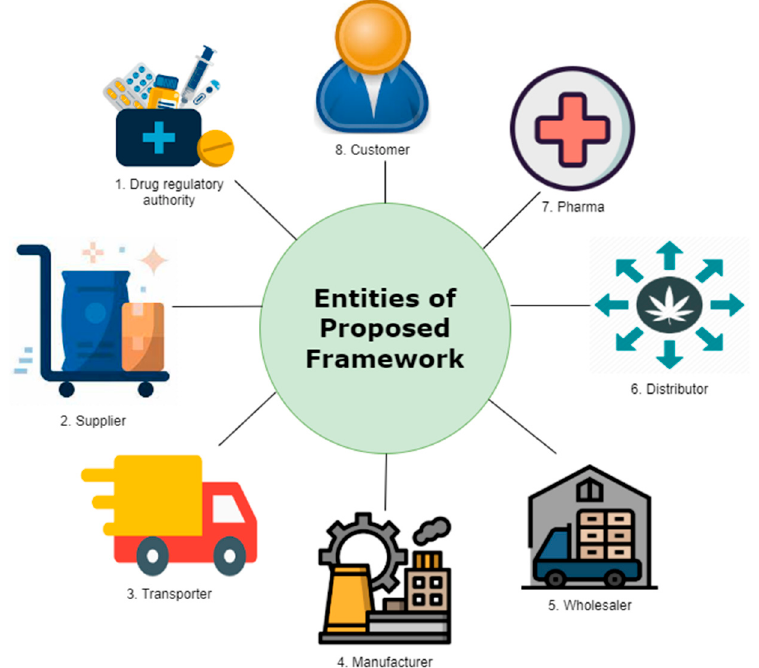
Figure 1. Key entities of the proposed framework .